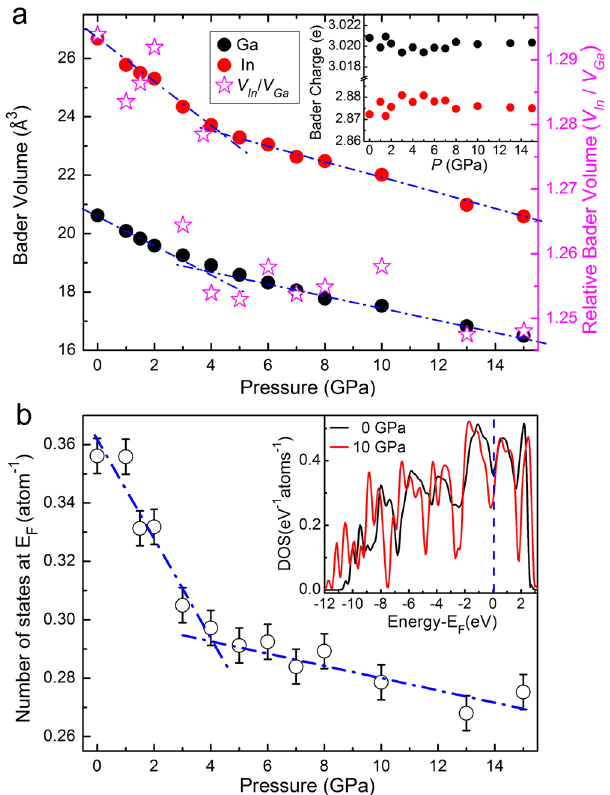
Figure 9. Theoretical Bader analysis and electronic density of states (DOS) for Ga 86 In 14 alloy. ( a ) The pressure dependence of Bader volume, the relative Bader volume of In to Ga, and Bader charge (inset). The blue dash dots are drawn to guide the eyes. ( b ) The DOS at the Fermi level as a function of pressure. The inset shows the total DOS of GaIn alloy at ambient pressure and 10 GPa. The Fermi level is set to 0.0